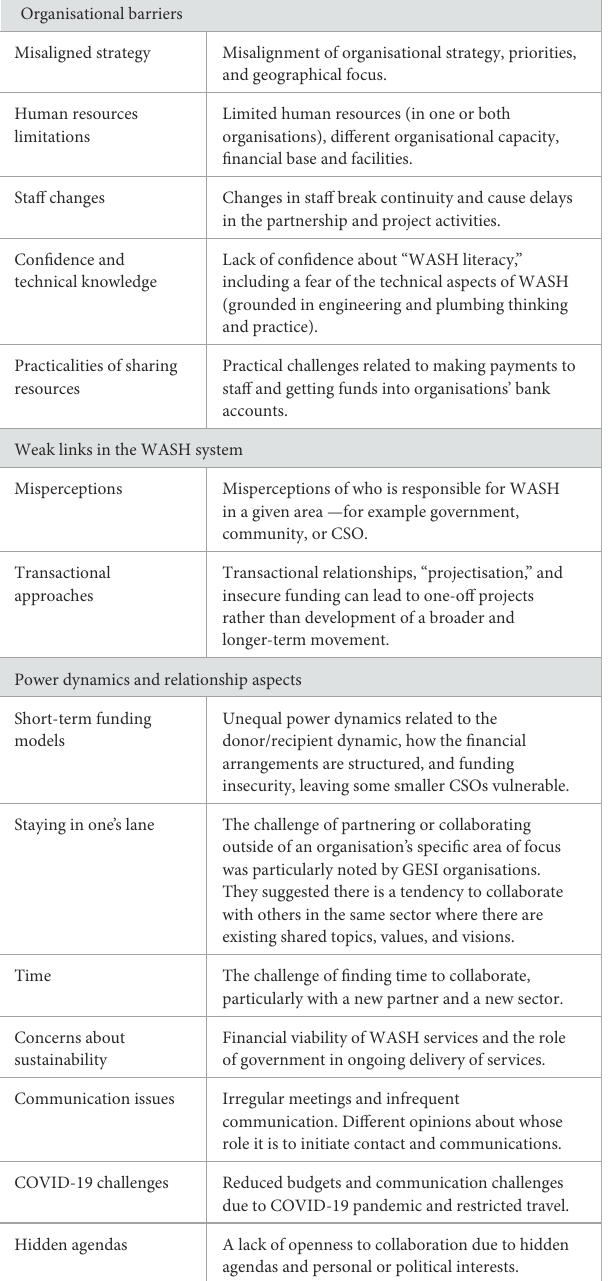
TABLE 2 Challenges reported by CSO interviewees ( n = 23) of partnerships between WASH and GESI organisations. Organisational